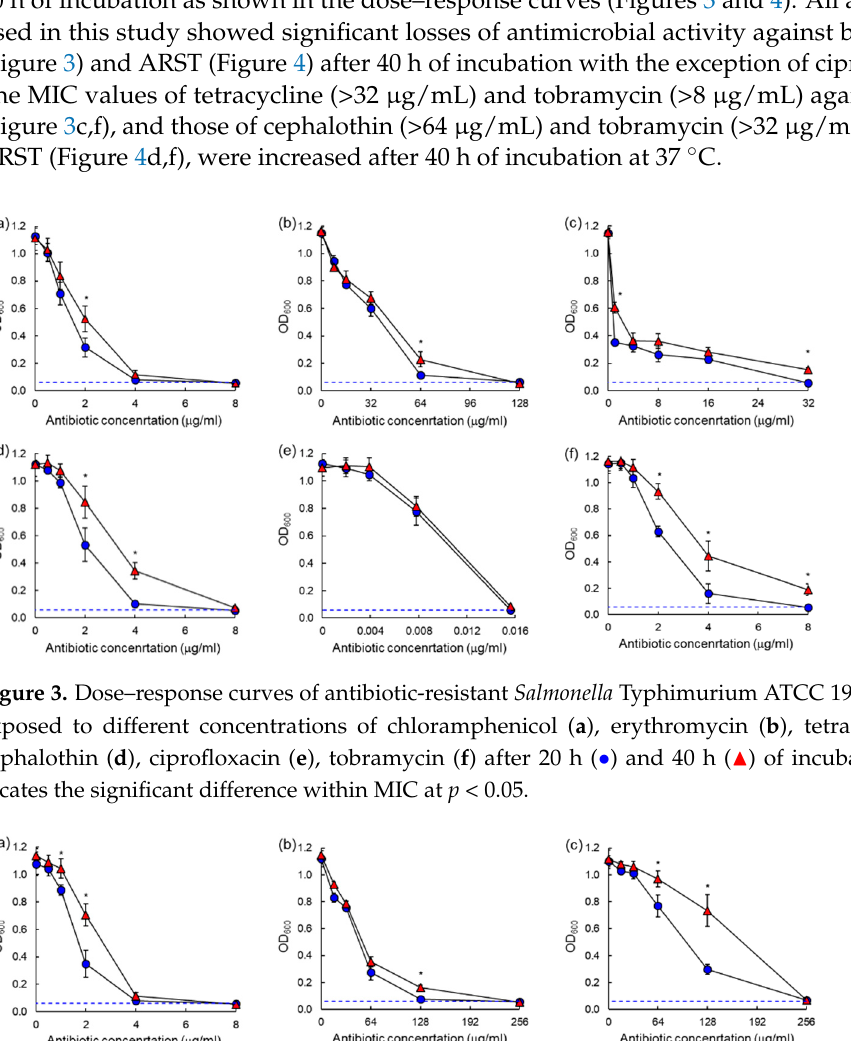
Figure 2. Growths of antibiotic-resistant Salmonella Typhimurium CCARM 8009 (ARST) exposed to ½ and 1 MICs of chloramphenicol ( a ), erythromycin ( b ), tetracycline ( c ), cephalothin ( d ), ciproflox- acin ( e ), tobramycin ( f ) at 0 h ( ■ ) and 10 h ( ■ ) delayed inoculation. * indicates the significant differ- ence within MIC at p < 0.05.